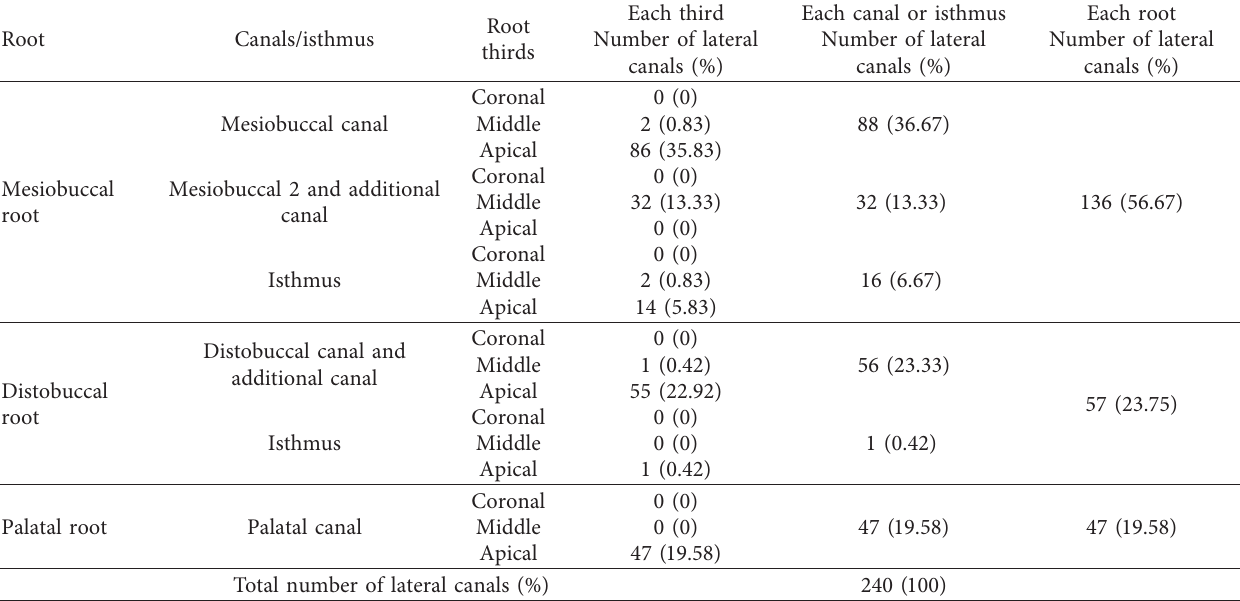
Table 2: Incidence of lateral canals from main root canals and isthmus